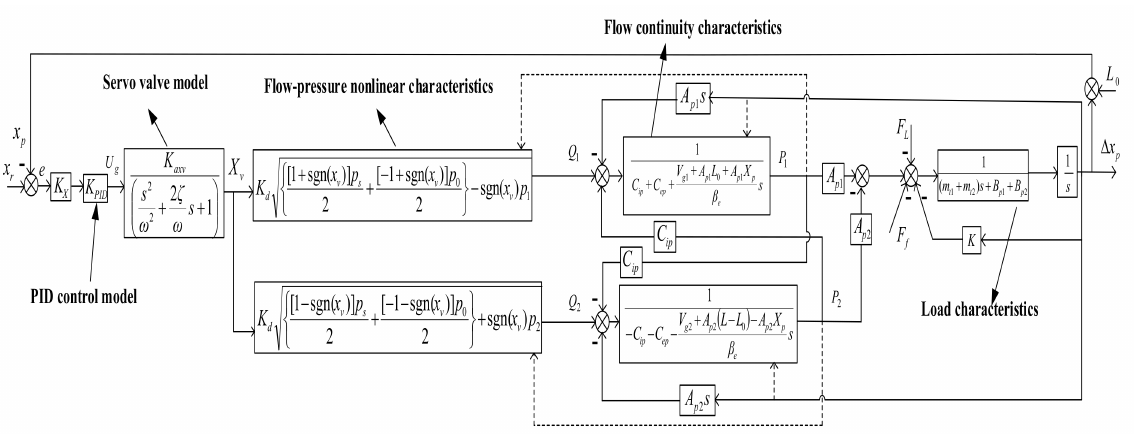
Figure 2. Block diagram of the HDU position closed-loop control